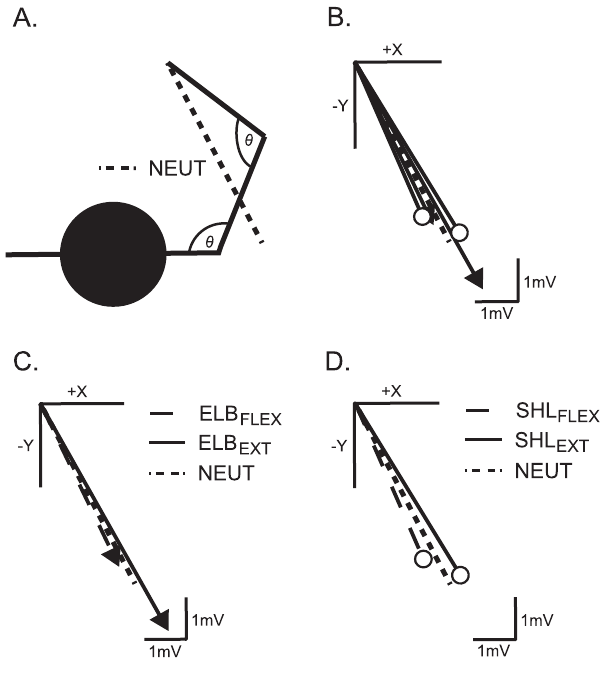
Figure 3. Results from the endpoint force vectors. A ) Representative figure showing the arm in the NEUT position and the corresponding group force vector response to stimulation. B ) Average force vector for all subjects in each position. The dashed line is the NEUT position. The lines with arrows are for the independent manipulation of the elbow angle, while the lines with circles correspond to changing shoulder angle. The same data from panel B is displayed in panels C and D , separated for the elbow and shoulder positions, respectively.